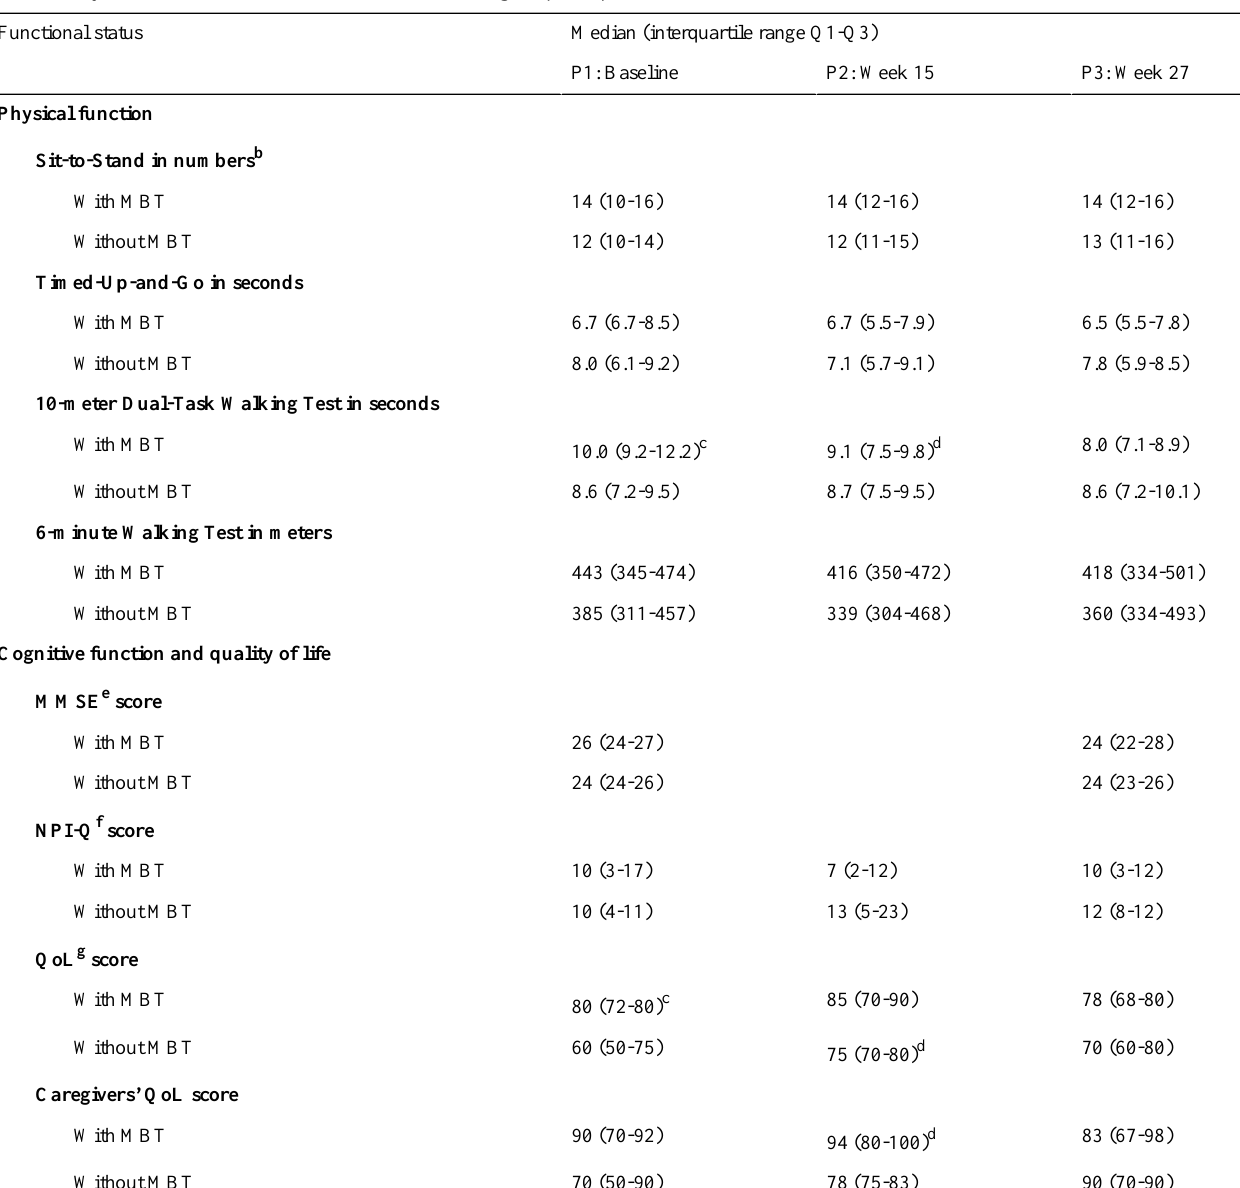
Table 3. Physical and mental function on 3 occasions among the participants who trained with (n=12) and without (n=11) MBT a at home.